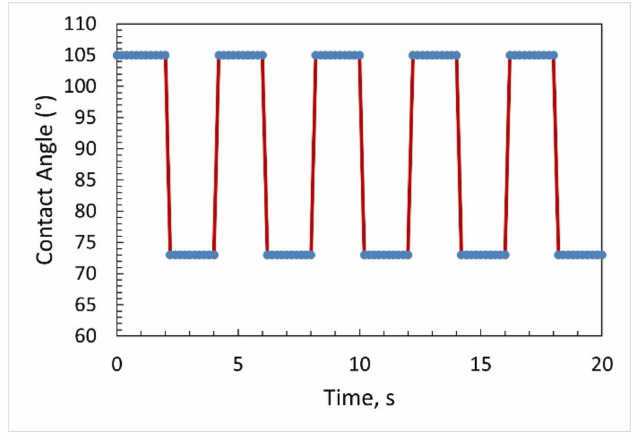
Figure 7. The contact-angle change as a function of time for several voltage cycles from 0 to 25 V DC in a bare ground sessile-drop electrowetting